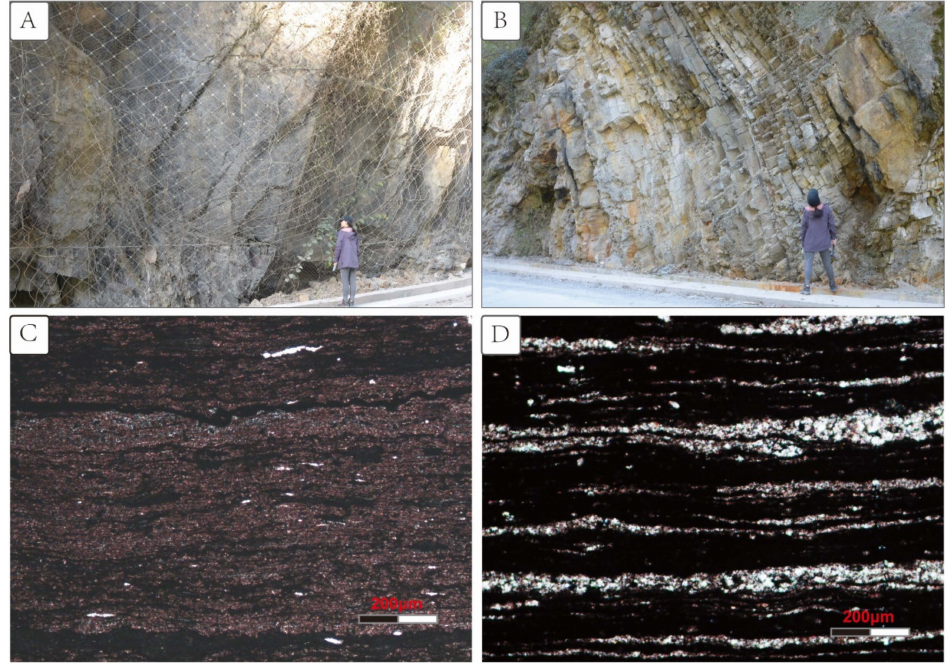
Figure 2. Field and microscopic photographs of the Heyu section. ( A ) Mid-thick bedded chert. ( B ) Thin-bedded chert and siliceous dolostone. ( C ) Carbonaceous shale. ( D ) Organic-rich siliceous